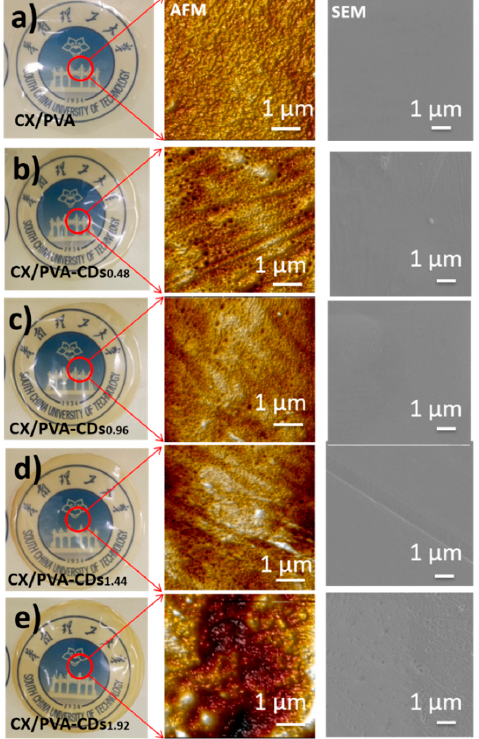
Figure 2. Digital images, atomic force microscopy (AFM) images, and SEM images of CX / PVA and CX / PVA-CDs: ( a ) CX / PVA; ( b ) CX / PVA-CDs 0.48 ; ( c ) CX / PVA-CDs 0.96 ; ( d ) CX / PVA-CDs 1.44 ; ( e ) CX / PVA-CDs 1.92